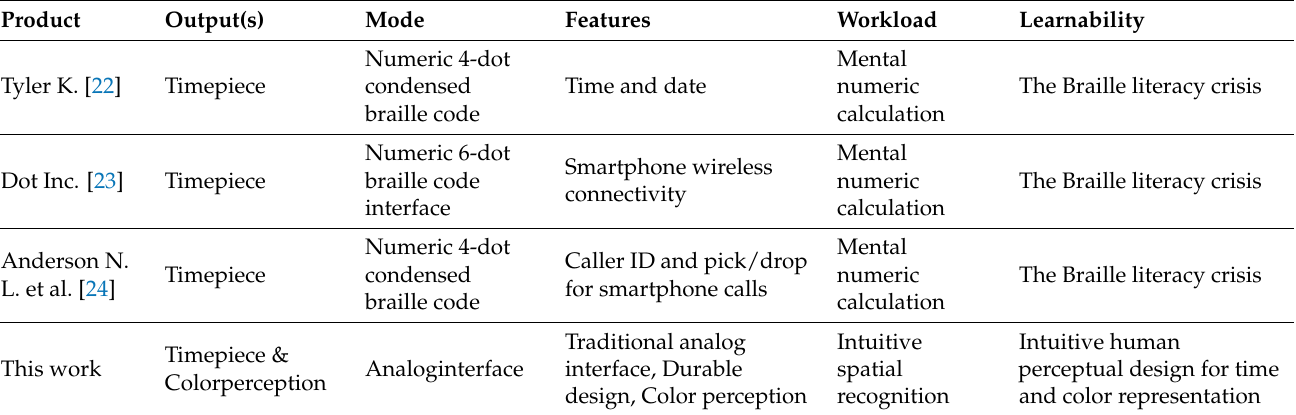
Table 6. Features and comparison of tactile watches.